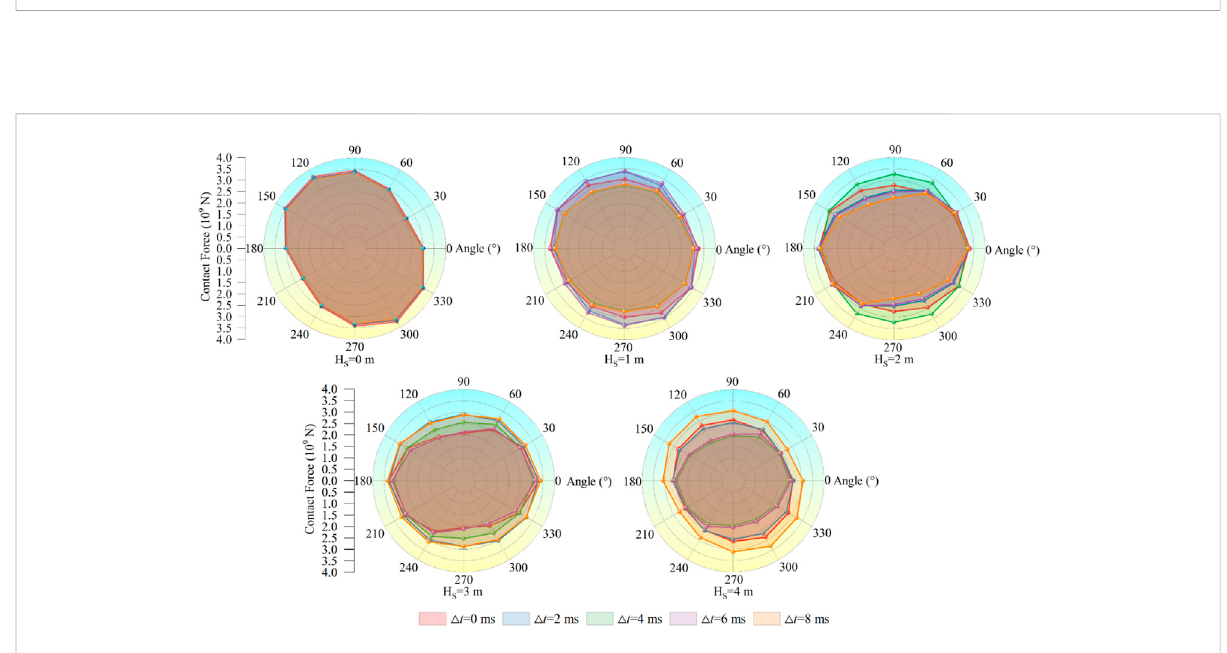
FIGURE 9 Contact force information after blasting in hard